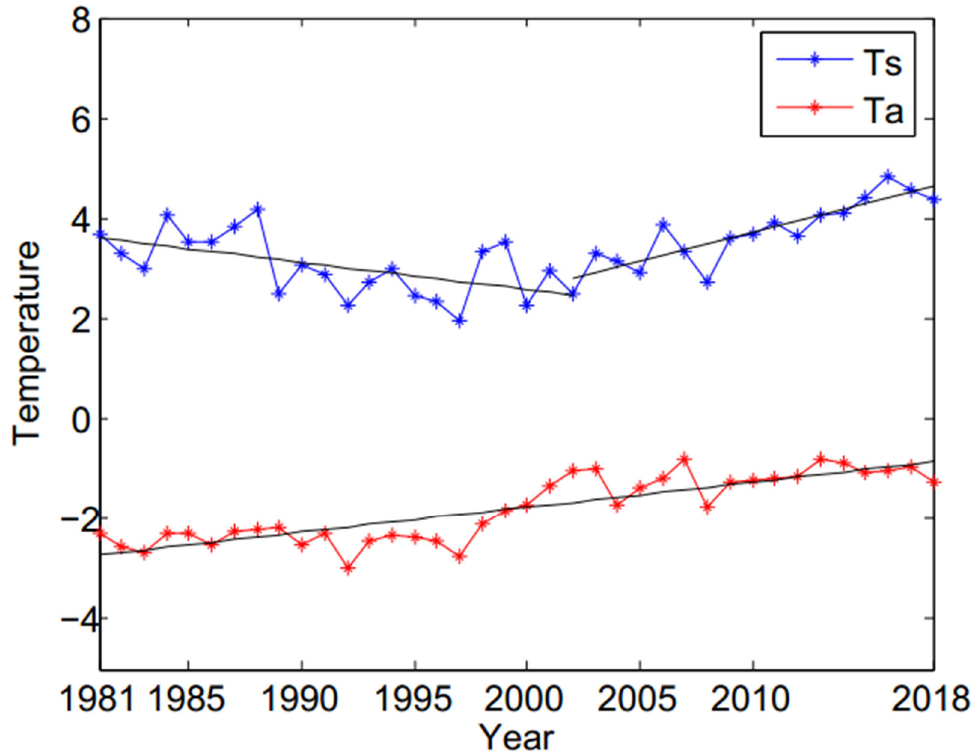
Figure 7. Variations in annual Ts ( ◦ C) and Ta ( ◦ C) in the Noah-MP simulation for the entire TP during the period 1981–2018. All of the trends are derived from linear least–squares regressions and are significant at the 95% confidence level using the Mann–Kendall trend test.